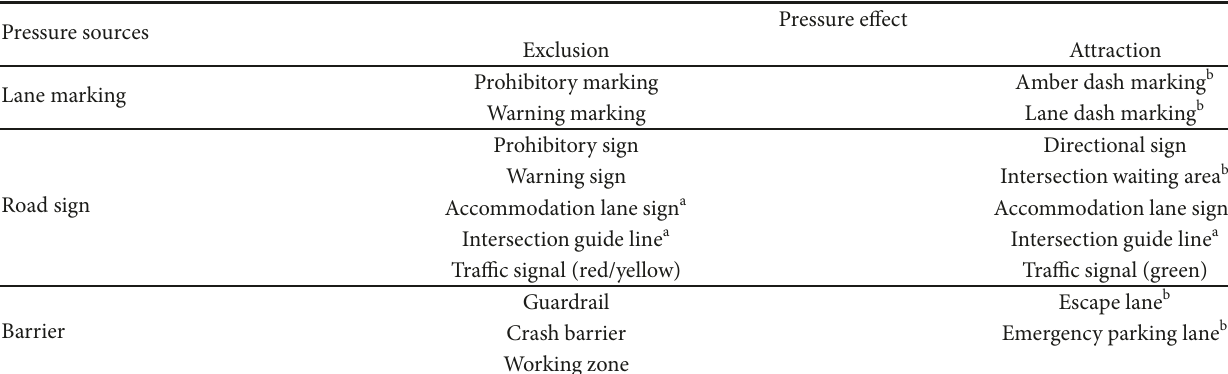
Table 3: The pressure effect of typical pressure sources.